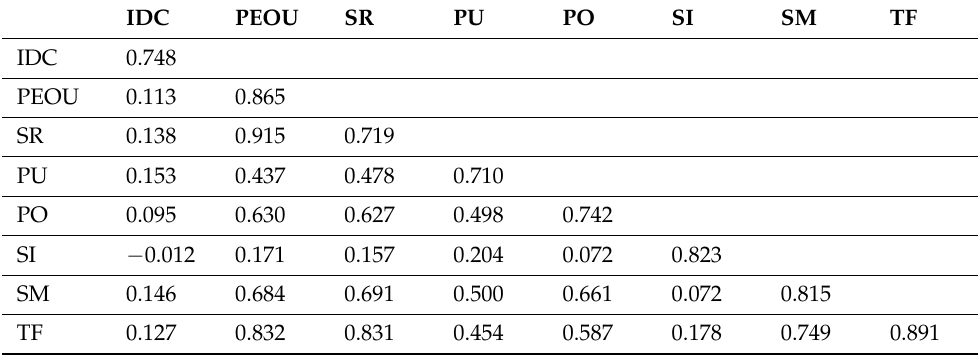
Table 7. Discriminants validity: Fornell–Larcker